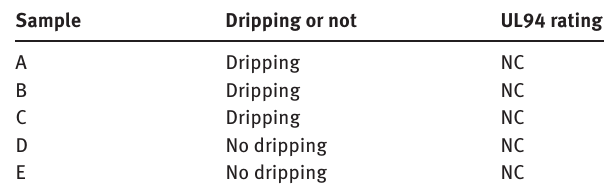
Figure 9: XRD patterns of OMMT and sample D at room temperature (RT-D).